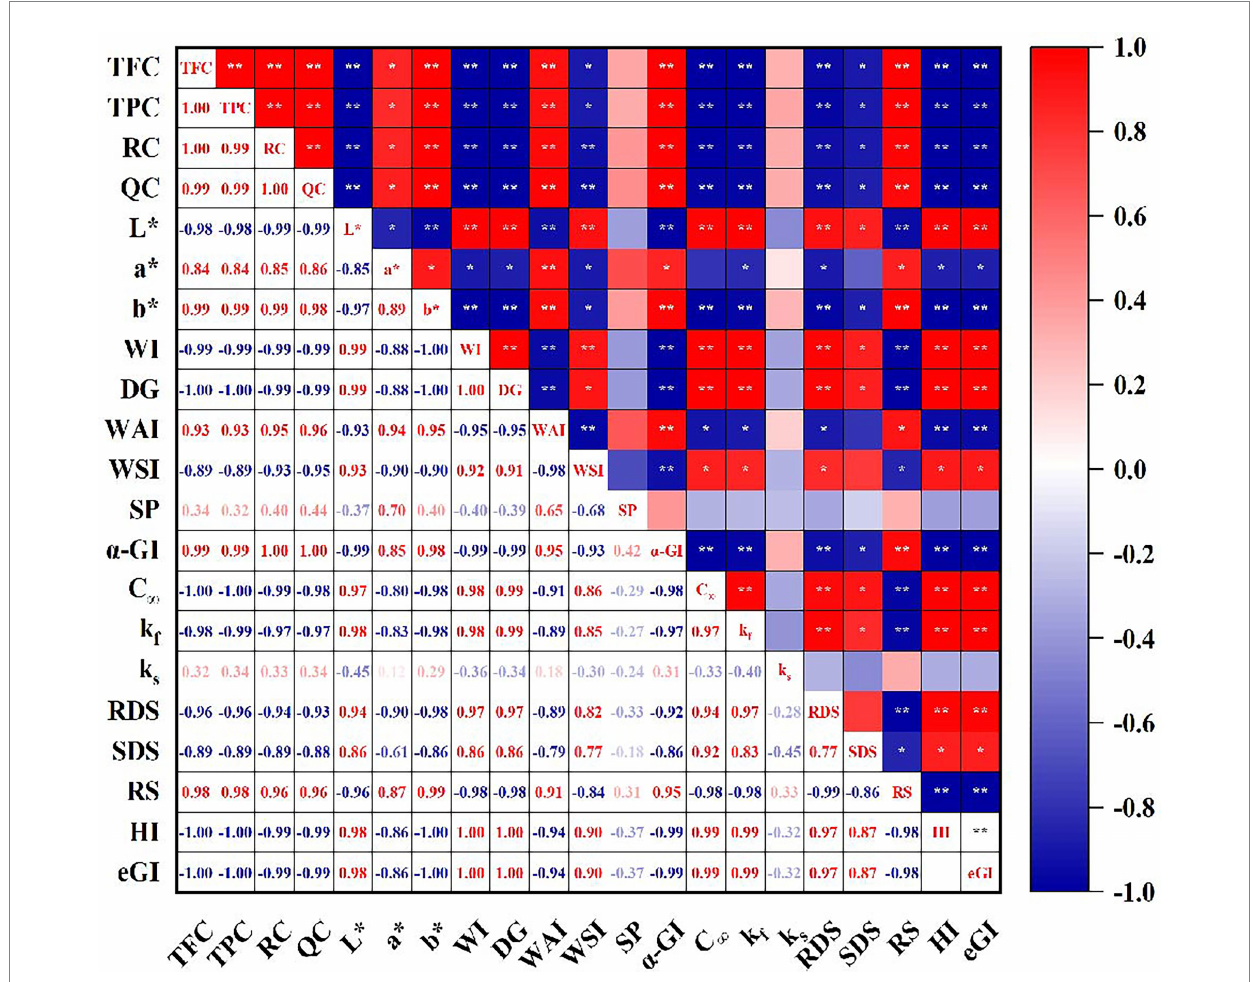
FIGURE 6 Correlation analysis among flavonoid compounds, physicochemical properties, color parameters, α -glucosidase inhibitory, digestive characteristics and estimated glycemic index. TFC, Total flavonoids content; TPC, Total phenolics content; RC, rutin content; QC, quercetin content; WI, whiteness index; DG, degree of gelatinization; WAI, water absorption index; WSI, water solubility index; SP, swelling power; C the reaction end point; k f , starch digestion rate constants for the fast step; k s , starch digestion rate constants for the slow step; RDS, rapidly digested starch; SDS, slowly digested starch; RS, resistant starch; HI, hydrolysis index; eGI, estimated glycemic index. * Represents significant difference between data, p < 0.05; ** represents extremely significant difference between data, p <